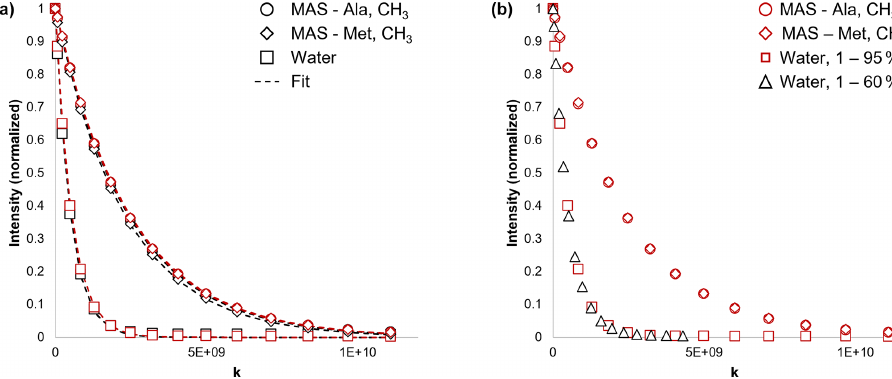
Figure 3. (a) Comparison of signal intensity versus the diffusion experiment parameter k = γ 2 G 2 δ 2 ( (cid:49) − ( δ/ 3) − ( τ/ 2)) for the alanine and methionine methyl signal of Met-Ala-Ser (MAS; circles and diamonds) and the water signal (squares). Black symbols indicate that the experiment was non-selective; red symbols indicate that selective excitation was used. The dashed lines are the fits to the data using Eq. (1). The adjusted R 2 values were all > 0.999. The diffusion time was (cid:49) = 250ms. (b) Comparison of signal intensity versus k = γ 2 G 2 δ 2 ( (cid:49) − ( δ/ 3) − ( τ/ 2)) for the water (squares and diamonds) and MAS Ala and Met methyl (circles and diamonds) signals using Sel- BPP-LED. Using the selective experiment, the applied gradient strength experienced by the water signal could be varied independently of the applied gradient strength experienced by MAS. Diamonds show that the applied gradient strength varied from 1%–60%. Using the selective excitation experiment, MAS signals were always exposed to an applied gradient varying from 1%–95%. The experiments were performed in triplicate, and the mean values are plotted. The diffusion time was (cid:49) =